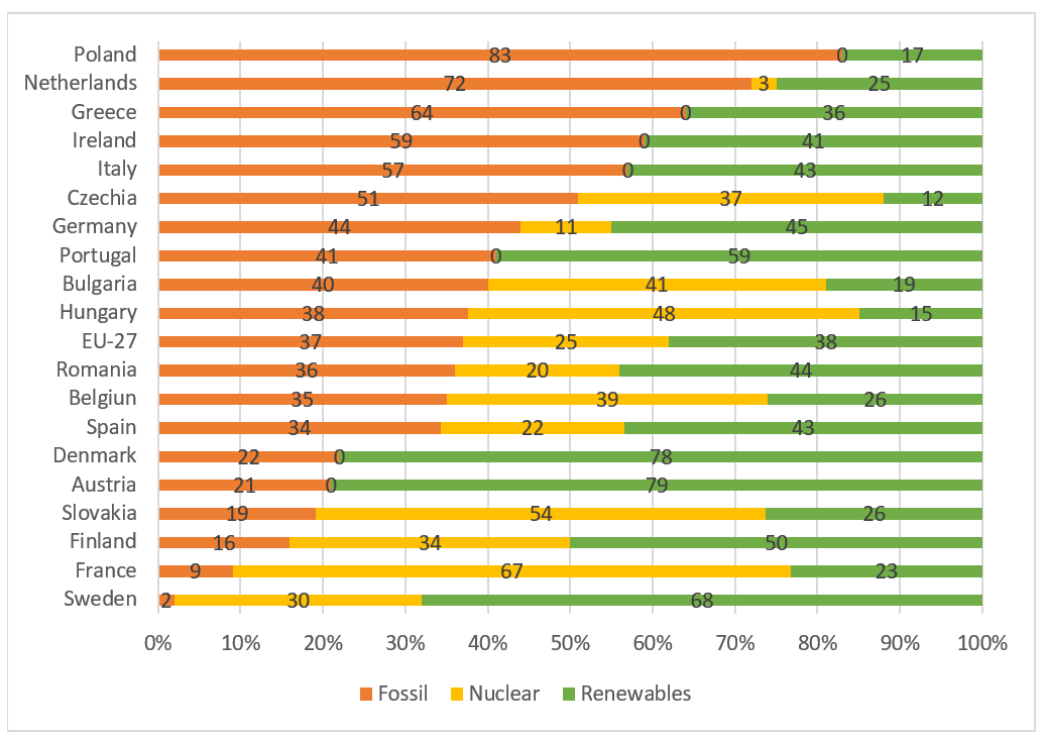
Figure 3. Fossil fuels vs. Renewables. Share of electricity generation. Source: Europe’s Pover Sector in 2020, published by Ember and Agora Energiewende on 25 January 2021.